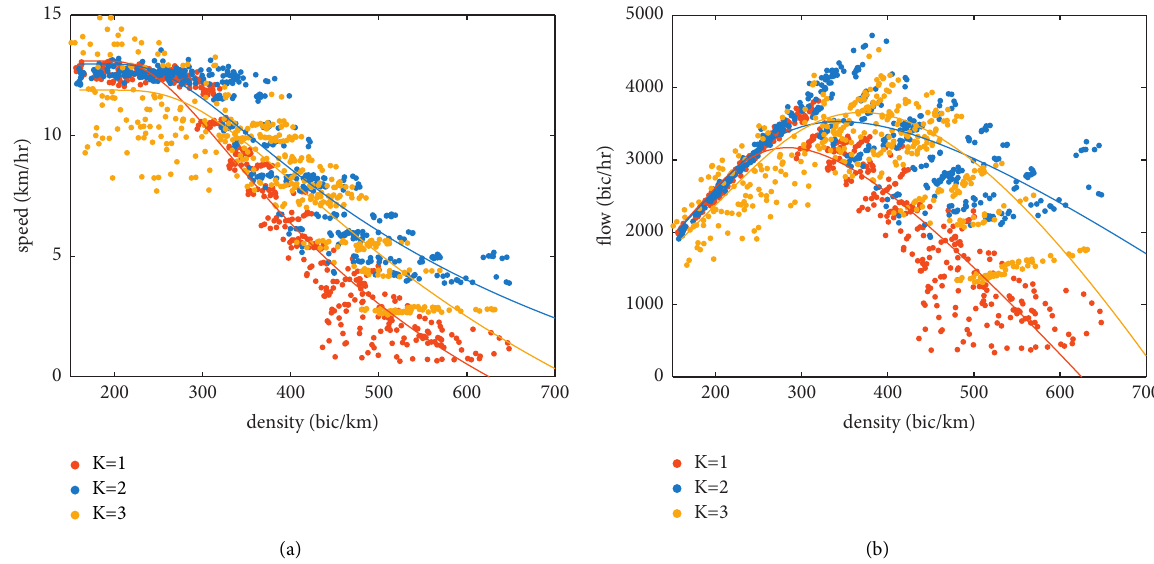
Figure 11: Fundamental diagrams under following group behavior with different group sizes. (a) Speed vs. density. (b) Flow vs.